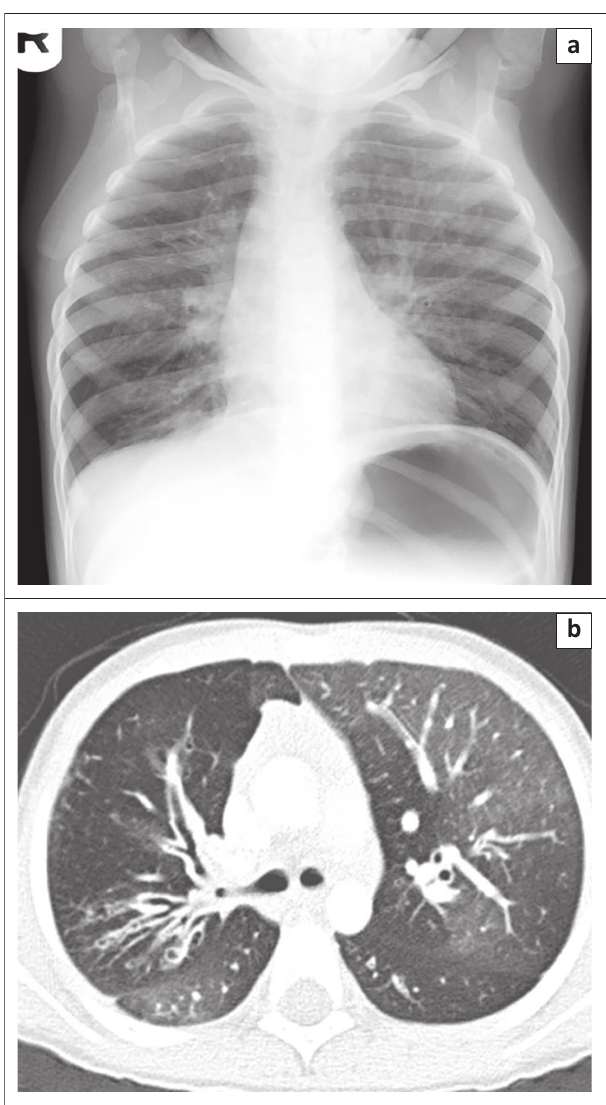
FIGURE 9: 10-year-old boy with HIV infection who presented with chronically worsening cough not responding to bronchodilator. (a) Frontal chest radiograph shows increased bronchovascular markings and reticulo-nodular opacifications. (b) Axial lung window CT image demonstrates areas of bronchiectasis and underlying small airway disease characterized by areas of mosaic attenuation due to underlying